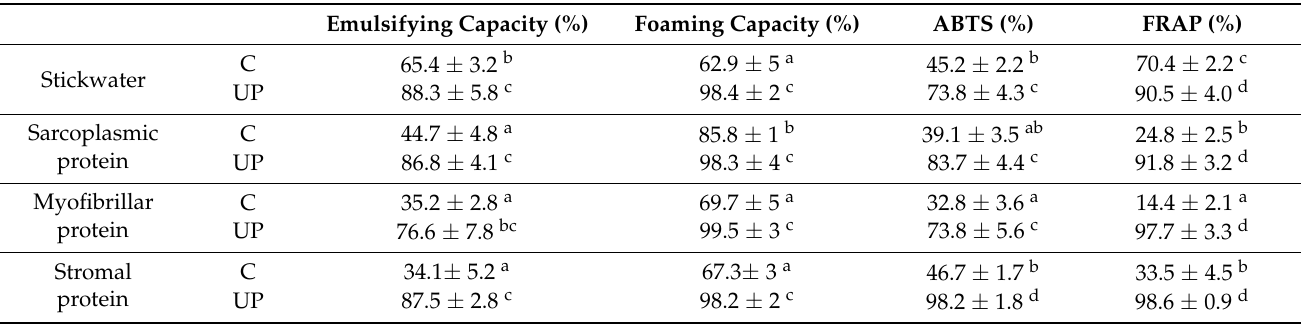
Table 2. Functional properties of stickwater